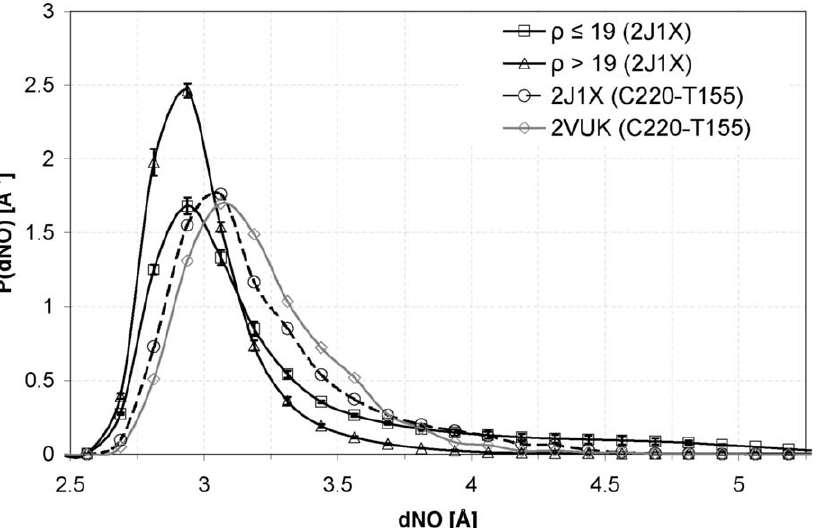
Figure 6. Distribution for the distance between the amidic N atom and the carbonylic O atom. HBs with r . 19 (well wrapped) in 2J1X ( m =2.949 and s =0.276), HBs with r # 19 (poorly wrapped) in 2J1X ( m =3.208 and s =0.564), CYS 220– THR 155 in 2VUK ( m =3.150 and s =0.288) and CYS 220– THR 155 in 2J1X ( m =3.143 and s =0.339). Attention should be paid to the tails of the distributions, that is, at large values of the N-O distance. These data come from the study of the three replicas for each